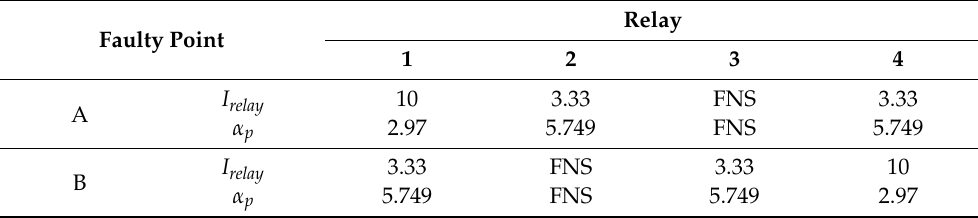
Table 2. Calculations of I relay (current through relay) and α p (constant) (Case